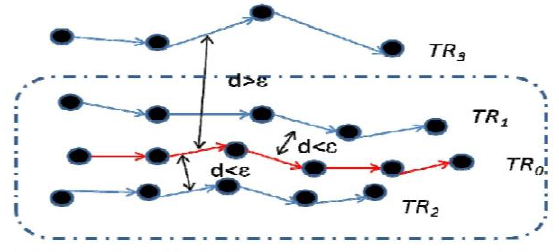
Figure 7. The illustration of trajectory